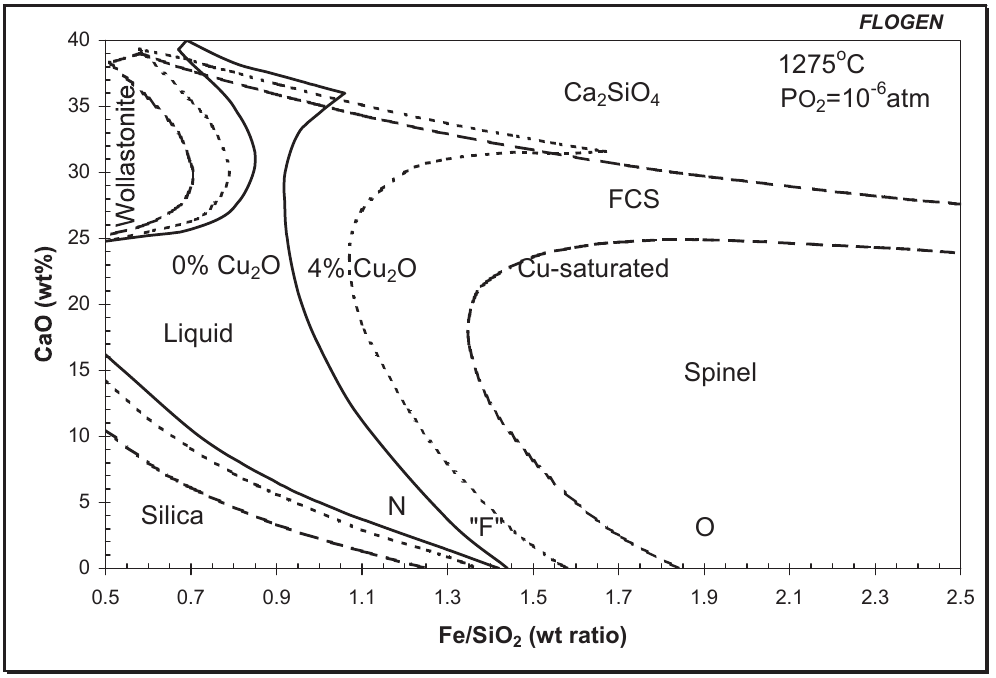
D 10 (cid:3) 6 atm. 2